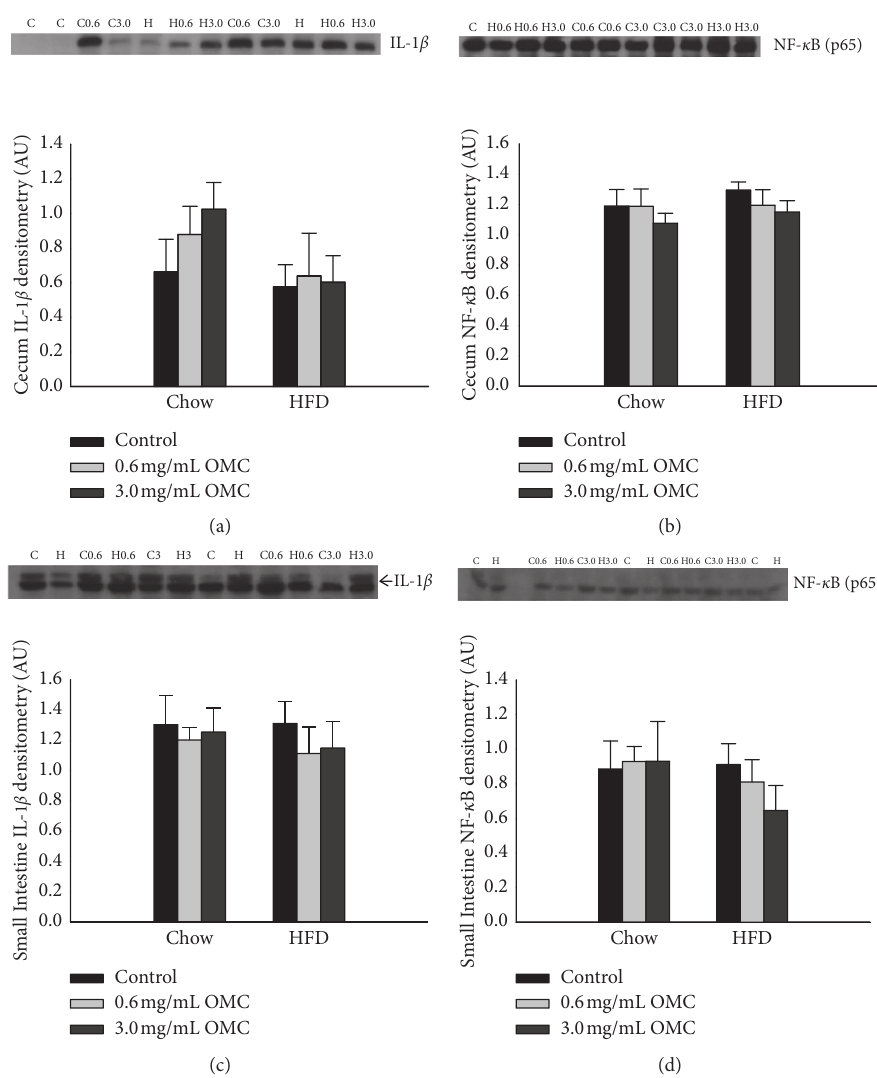
Figure 1: Protein expression of inflammatory cytokines in the cecum and small intestine. (a) IL-1 β protein expression in cecum ho- mogenates from rats in all treatment groups ( n � 6/group), p � 0 . 702. Effects of OMC supplementation on IL-1 β expression, p � 0 . 602. HFD vs OMC interaction, p � 0 . 783. (b) NF- κ B (p65) protein expression in cecum homogenates from rats in all treatment groups ( n � 6/ group), p � 0 . 362. Effects of OMC supplementation on NF- κ B expression, p � 0 . 803. HFD vs OMC interaction, p � 0 . 855. (c) IL-1 β protein expression in small intestine homogenates from rats in all treatment groups ( n � 6/group), p � 0 . 603. Effects of OMC supplementation on IL-1 β expression, p � 0 . 574. HFD vs OMC interaction, p � 0 . 931. (d) NF- κ B (p65) protein expression in small intestine homogenates from rats in all treatment groups ( n � 6/group), p � 0 . 746. Effects of OMC supplementation on NF- κ B expression, p � 0 . 304. HFD vs OMC interaction, p � 0 . 586. Densitometry values were normalized to Coomassie for all samples, and data are expressed as mean ± SEM and analyzed by two-way